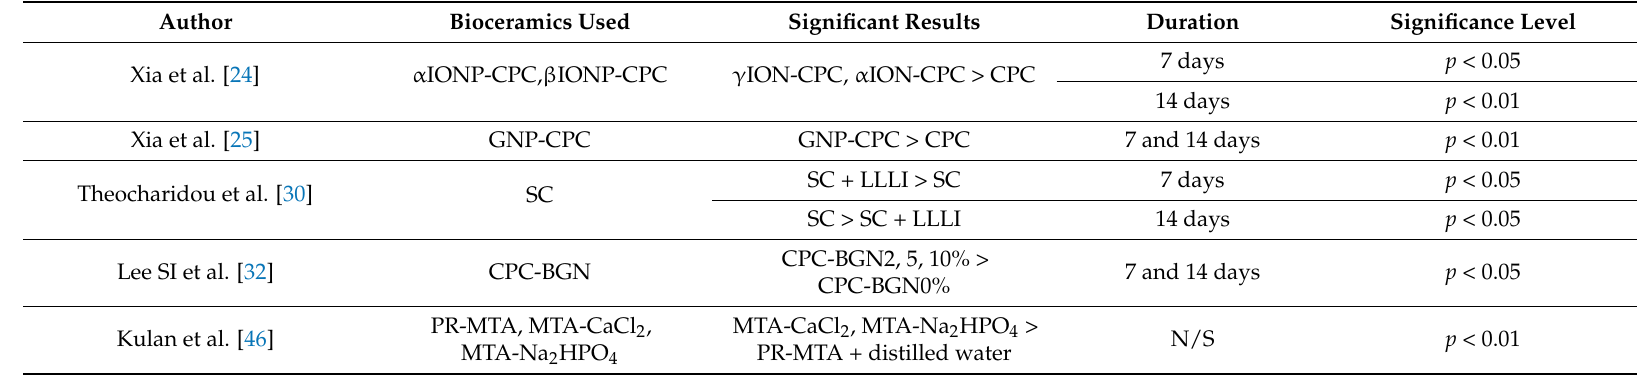
Table 15. Summary of the results of included studies showing significant differences between a bioceramic material with an additive and the bioceramic material itself for ALP